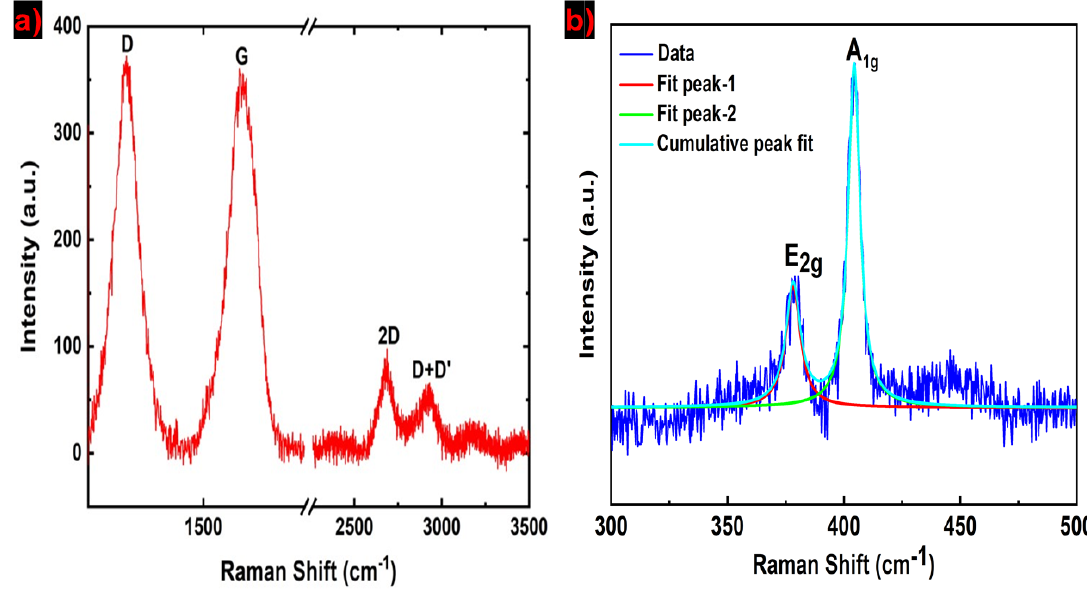
Figure 2. ( a ) Raman spectrum of NDG nanosheets; ( b ) Raman spectrum and their Lorentzian fits of MoS 2 nanosheets